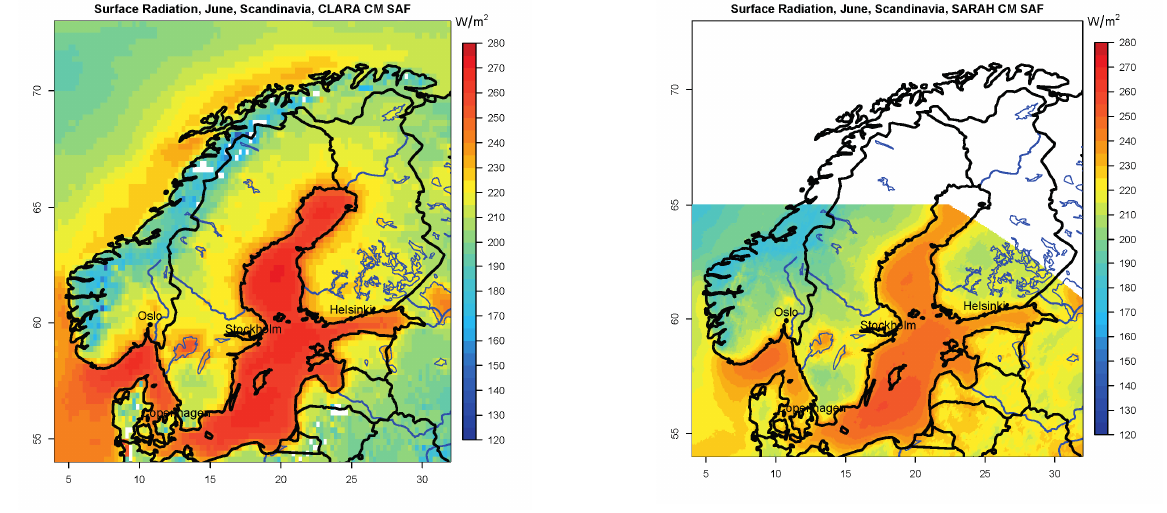
Figure 2. ( Left ) The 1982–2009 mean SSR in June over Scandinavia from CLARA-A1-SIS. ( Right ) The 1983–2013 mean SSR in June over Scandinavia from